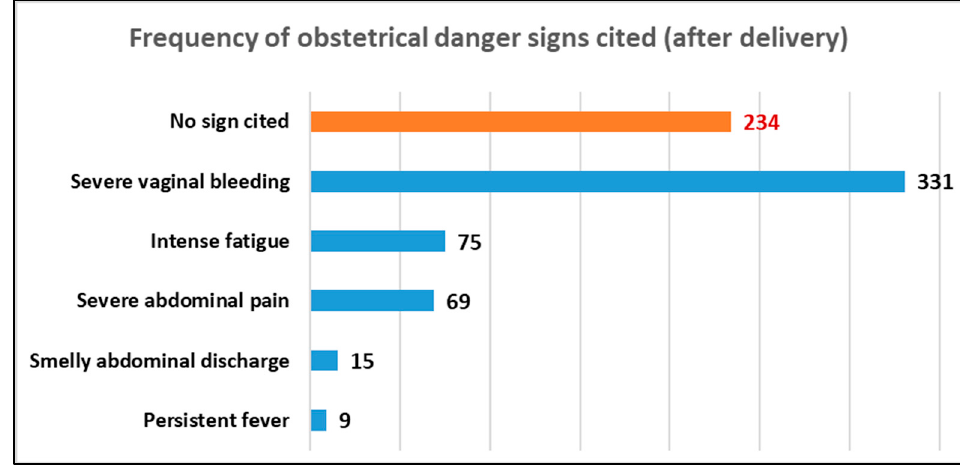
Figure 3. Frequency of ODS cited during postpartum (after delivery).